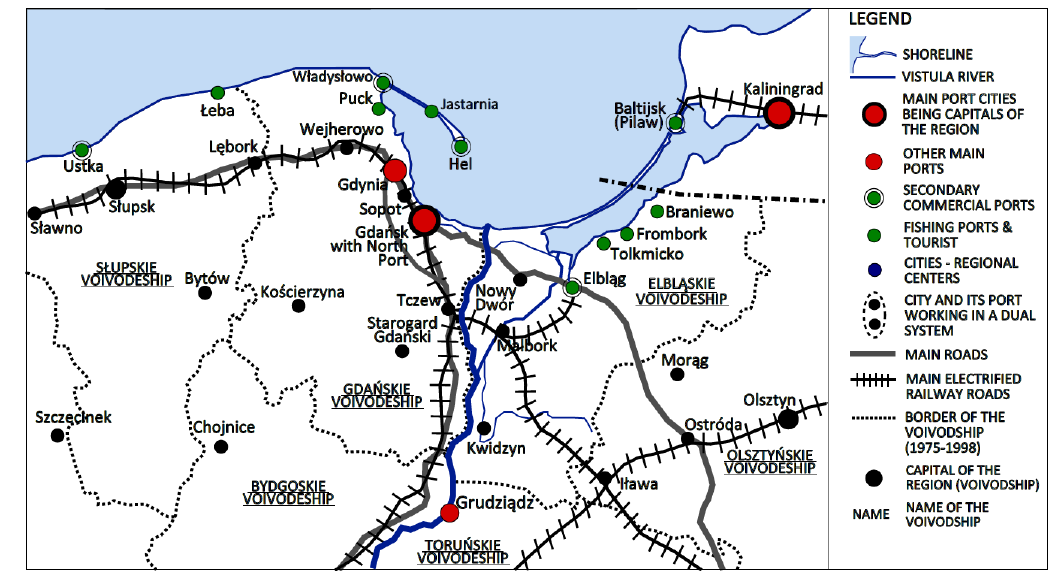
Figure 7. Gdańsk Bay port region geography during the period of